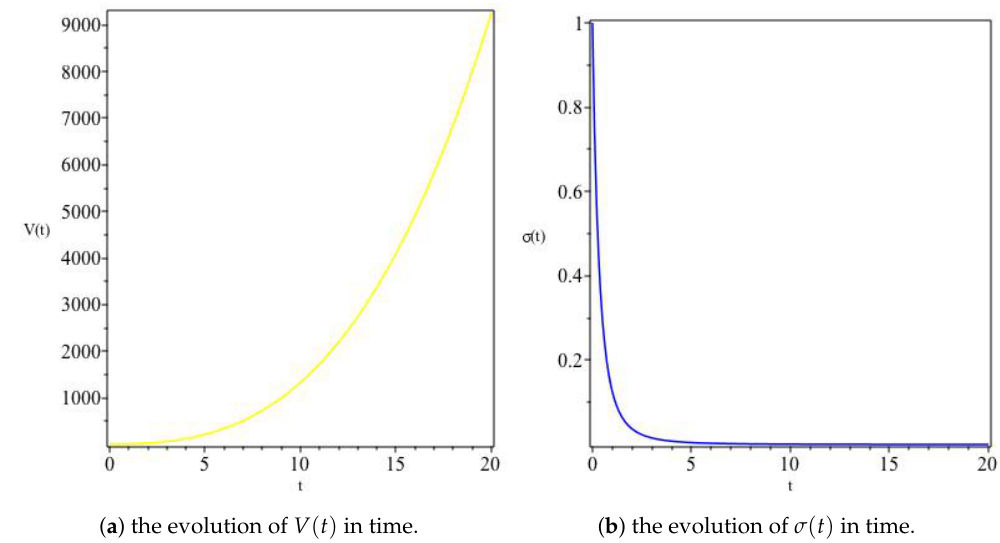
Figure 2. The variation of V and σ for α = − 2 , β = 2 . In ( a ), we see a monotonically increasing volume due to the expanding scale factor, whereas ( b ) shows an initially anisotropic universe rapidly isotropizing at alate